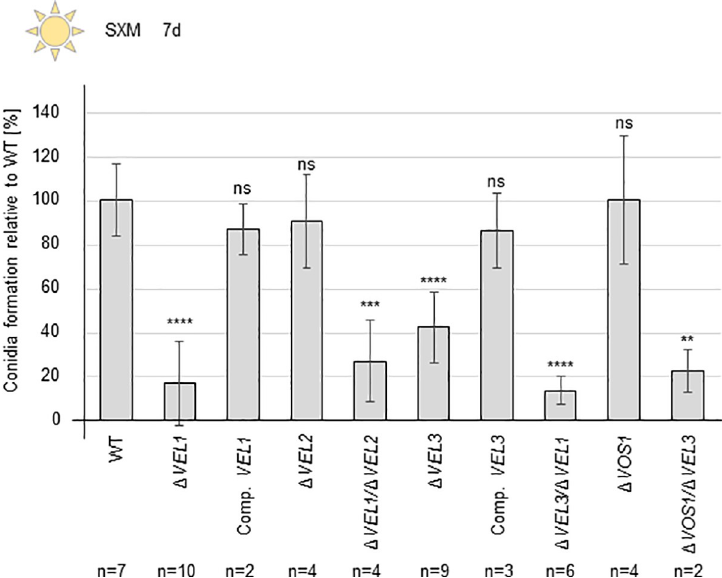
Fig 4. V . dahliae conidiospore formation requires the VEL1 and VEL3 genes. 2x10 5 freshly harvested spores were inoculated in liquid simulated xylem medium (SXM) and incubated at 25˚C for seven days under constant agitation and light. The conidia formation was quantified relative to the wild type (WT). Each experiment was performed with three technical replicates (n = 1). Two individual transformants were used for the following strains: Δ VEL1 , Δ VEL2 , Δ VEL1 / Δ VEL2 , Δ VEL3 , Δ VEL3 / Δ VEL1 and Δ VOS1 . Bars represent the mean values of all experiments and error bars correspond to standard deviations. VEL1 and VEL3 deletion and double deletion strains are impaired in conidia formation. VEL2 and VOS1 are dispensable for conidiation. Observed defects were restored in the corresponding complementation strains. Significant differences were calculated by t-test and indicate: �� :p < 0.01; ��� :p < 0.001; ���� : p = 0.0001; ns: not